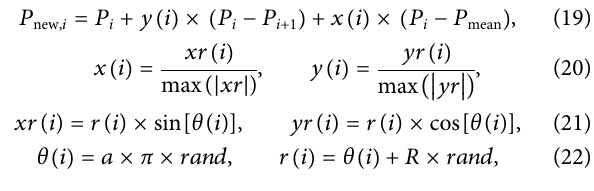
Frontiers in Energy Research |